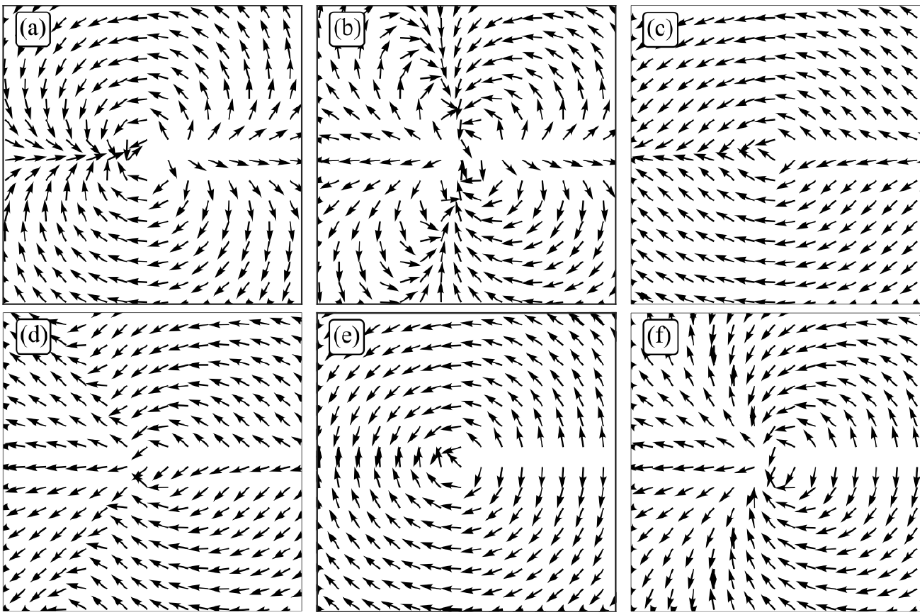
Figure 2. The distributions of linear polarization vectors in the cross section of the field (1) for m = 2 ( a , c , e ) and m = 3 ( b , d , f ), and a = 1/2 ( a , b ), a = 3/2 ( c , d ), a = 1 ( e , f ).